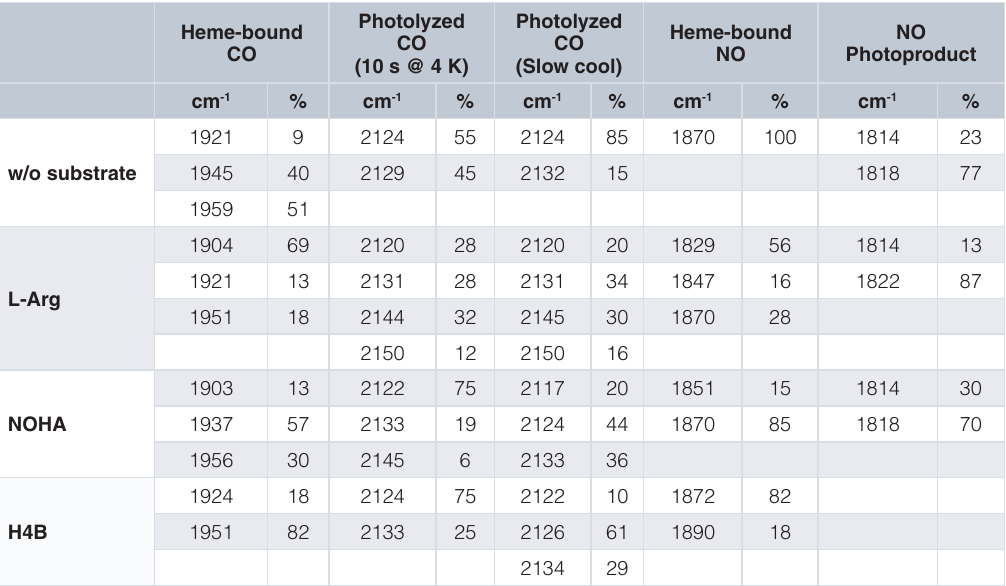
Table 1. Positions and fractional areas of the IR stretching bands of heme-bound and photodissociated CO and NO ligands in